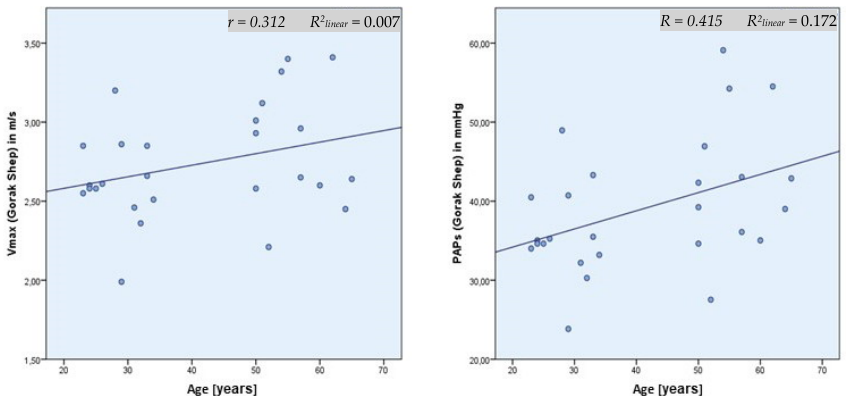
Figure 2. Comparison of mean values of age subgroups (<50 years ( n = 14), >50 years ( n = 13)).